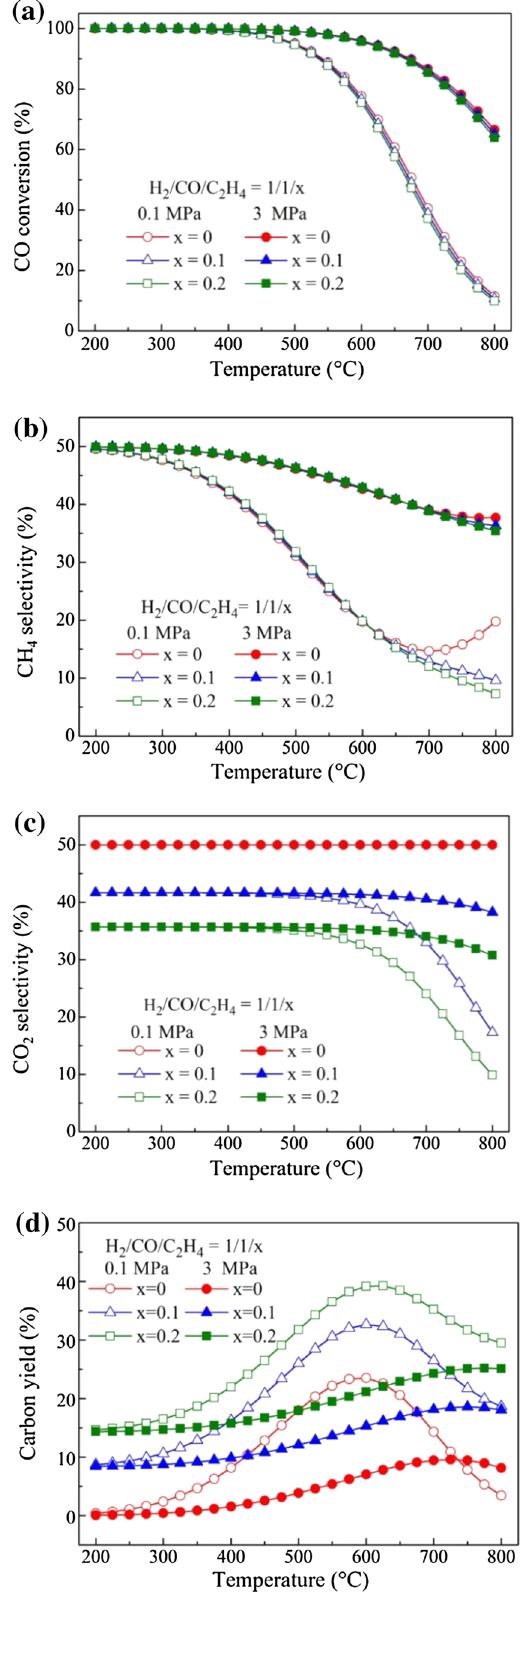
c Fig. 9 Effect of C